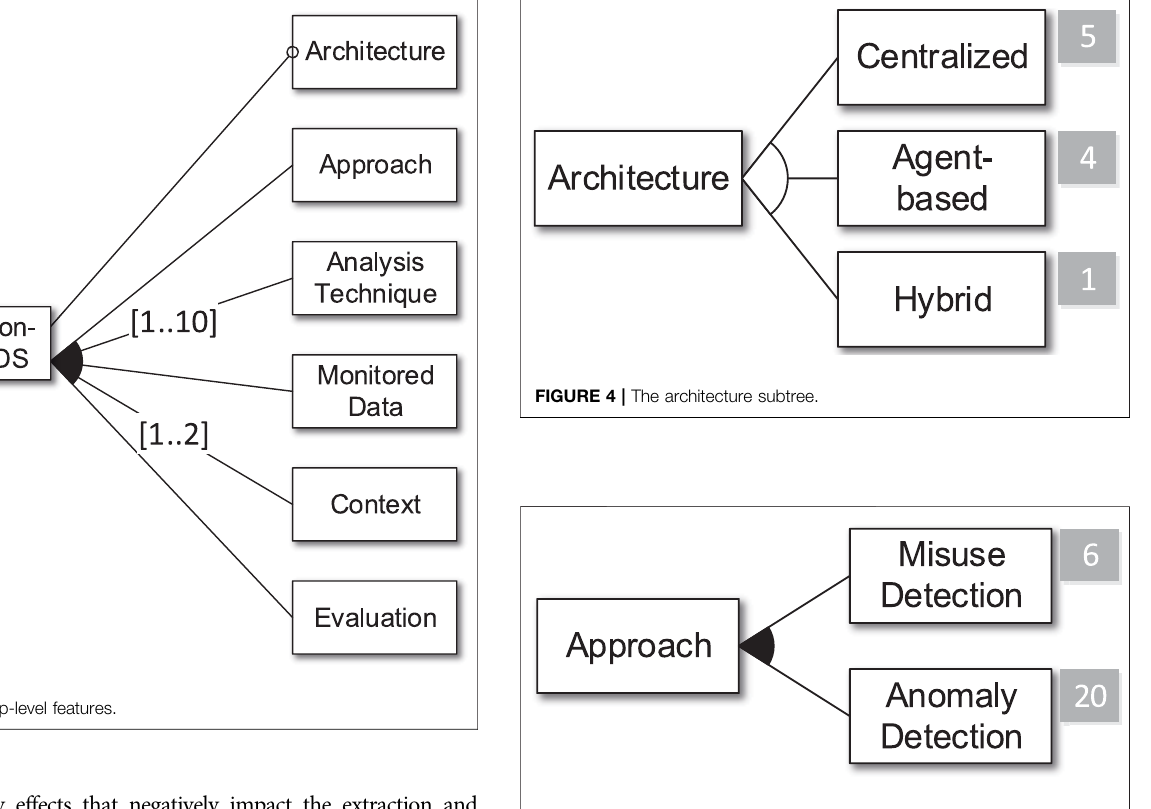
FIGURE 5 | The approach